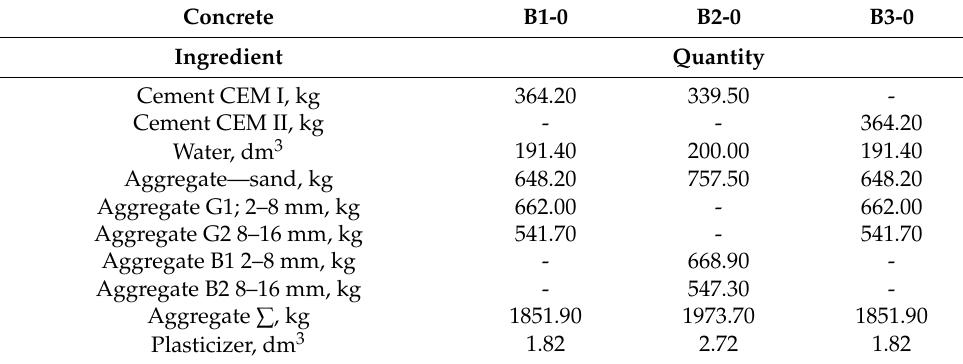
Table 2. Composition of B1-0, B2-0 and B3-0 control concretes.